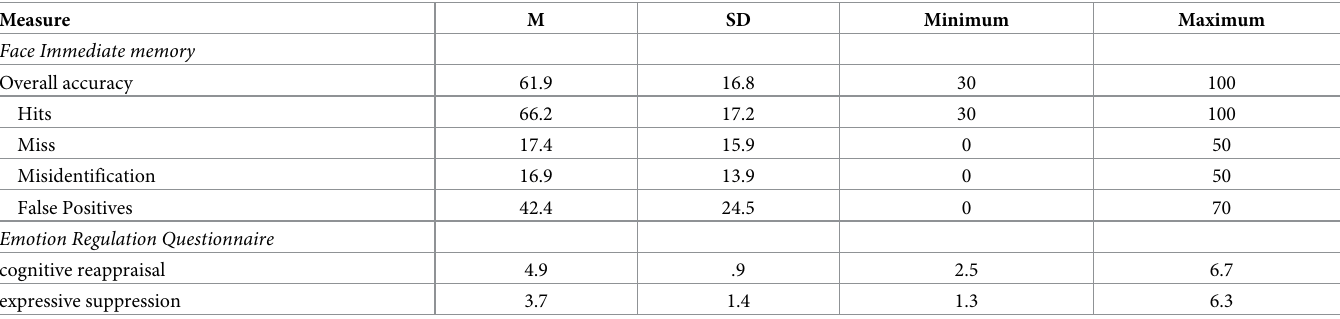
Table 1. Descriptive statistics for participants’ responses on the face immediate memory task (%) and the ERQ. Measure M SD Minimum Maximum